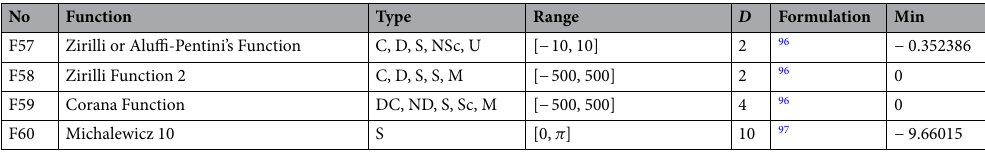
Table 2. Details of the fixed-dimensional benchmark mathematical